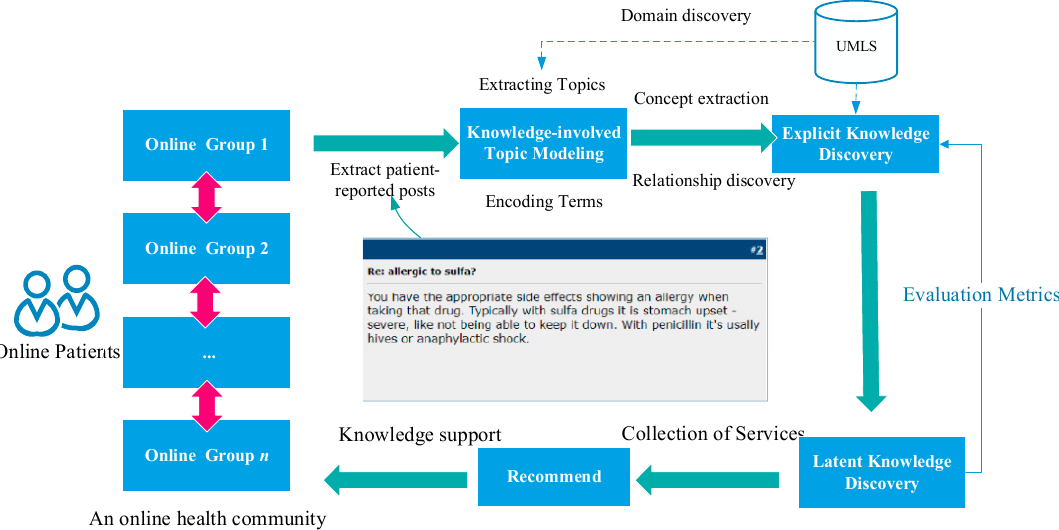
Figure 2. Overview of the domain-knowledge support framework in online health communities. In OHCs, a patient-reported post is defined as